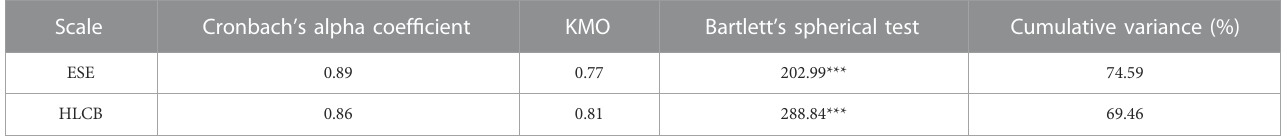
TABLE 2 Reliability and validity of scales. Scale